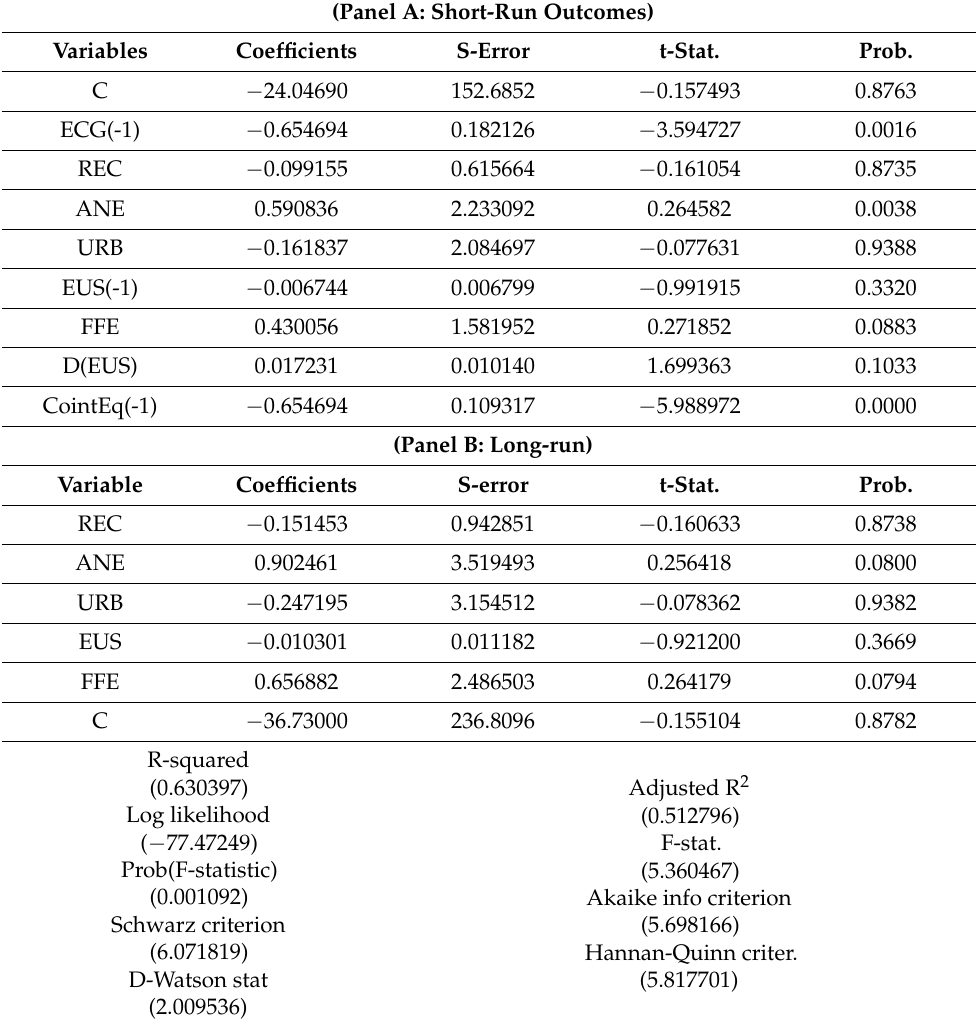
Table 8. Findings of short- and